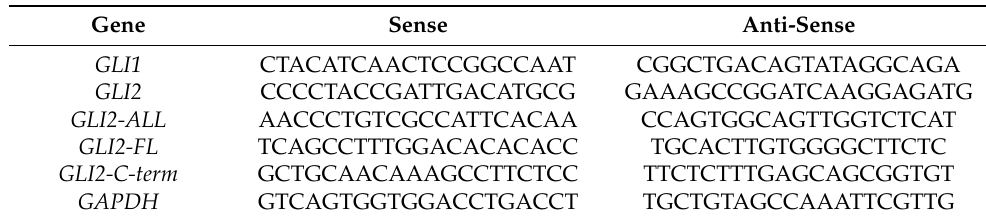
Table A1. Primers used in this study. Gene Sense